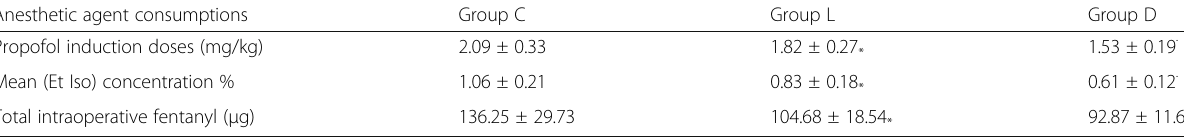
Table 4 Anesthetic agent consumptions during intraoperative period (mean ± standard deviation) Anesthetic agent consumptions Propofol induction doses